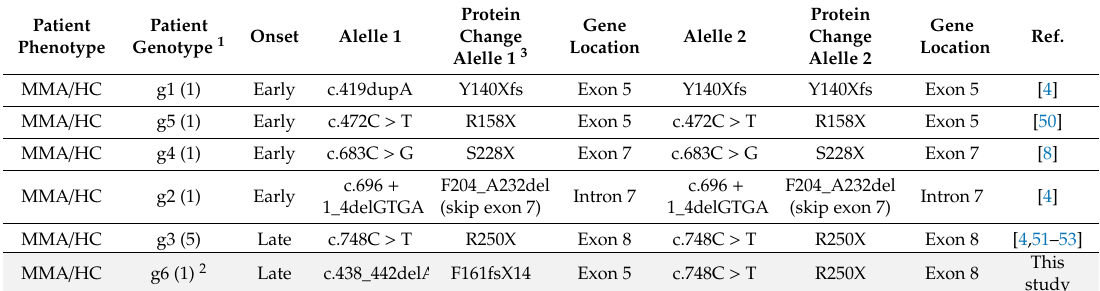
Table 2. MMADHC mutations and genotype in patients with MMA / HC cblD defect.